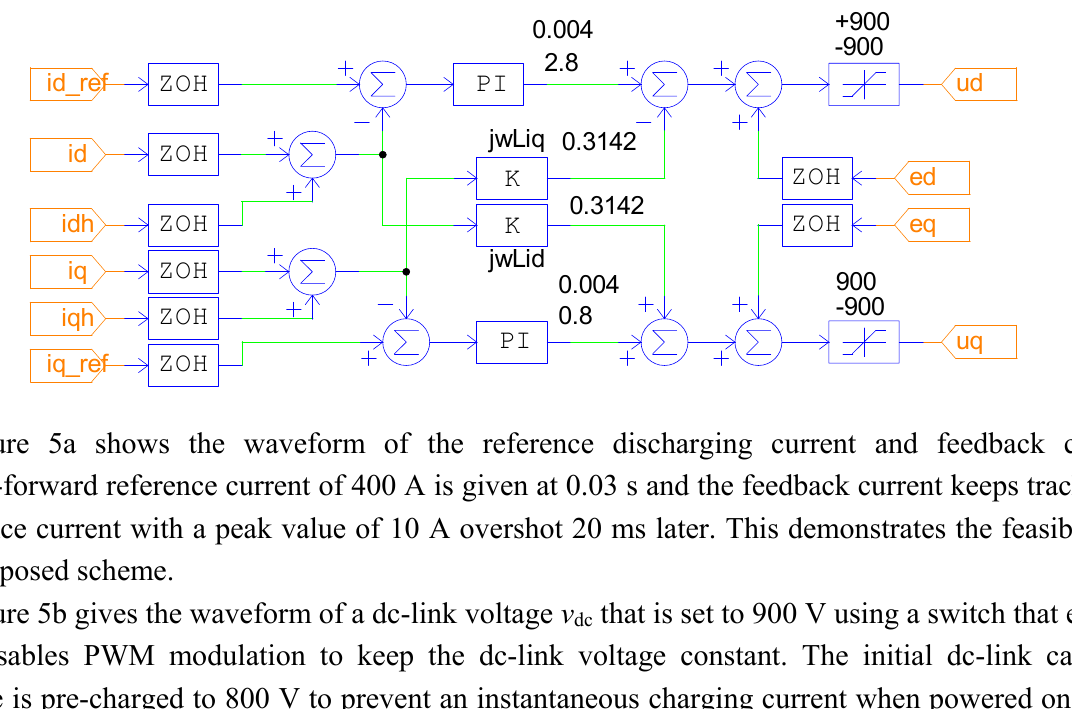
Figure 4. Inner active and reactive current component control using PI